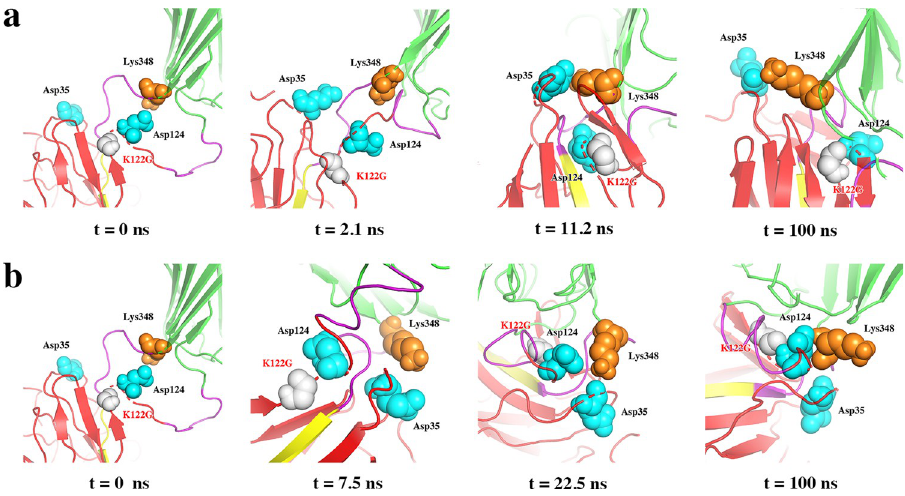
Fig 4. Structure in simulated trajectory of K122G. (a) and (b) are two simulation results. (a) Lys348 preferred Glu35 to Asp124 in terms of electrostatic attraction. (b) Lys348 preferred Asp124 to Glu35 in terms of electrostatic attraction.